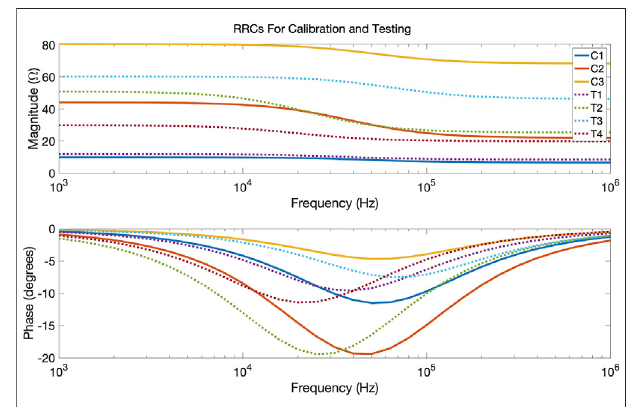
FIGURE 5 | Bode plot of the calibration and test RRC networks used. Values for the RRCs can be found in Table 1